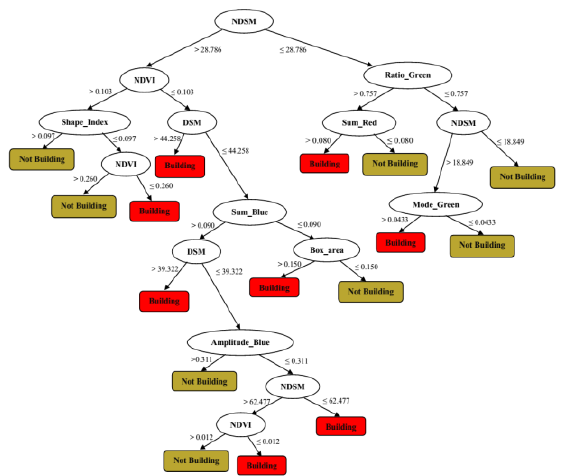
Figure 2. C4.5 decision tree classification model Table 3. Extracted rules from decision tree Rule